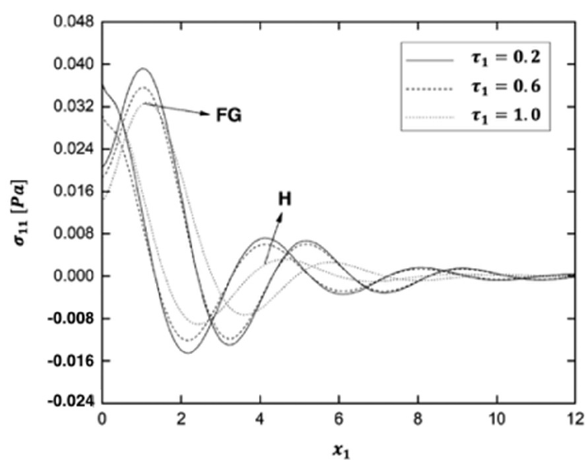
Figure 14. Variation of the thermal stress wave σ 11 along x 1 − axis in the functionally graded (FG) and homogeneous (H) fiber-reinforced plates under different values of time characteristic of the laser pulse.